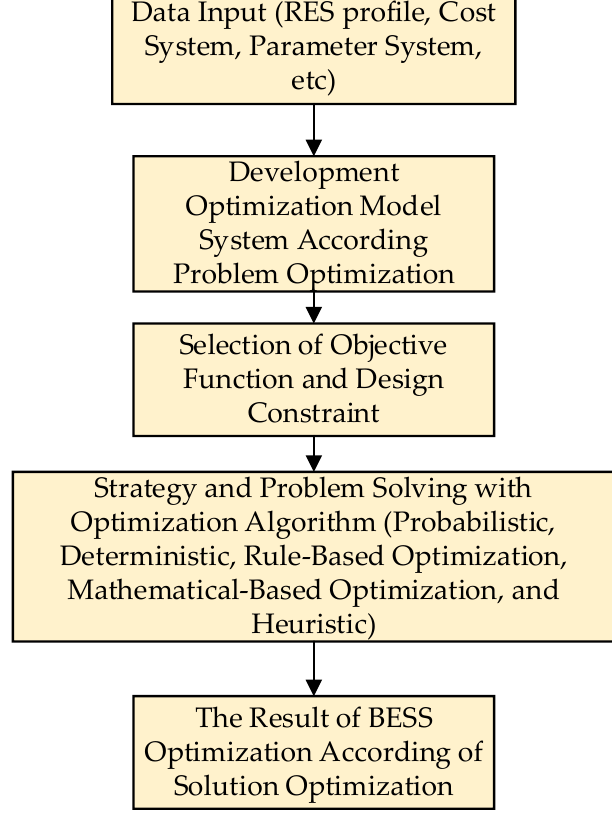
Figure 12. Flowchart of optimization of BESS.